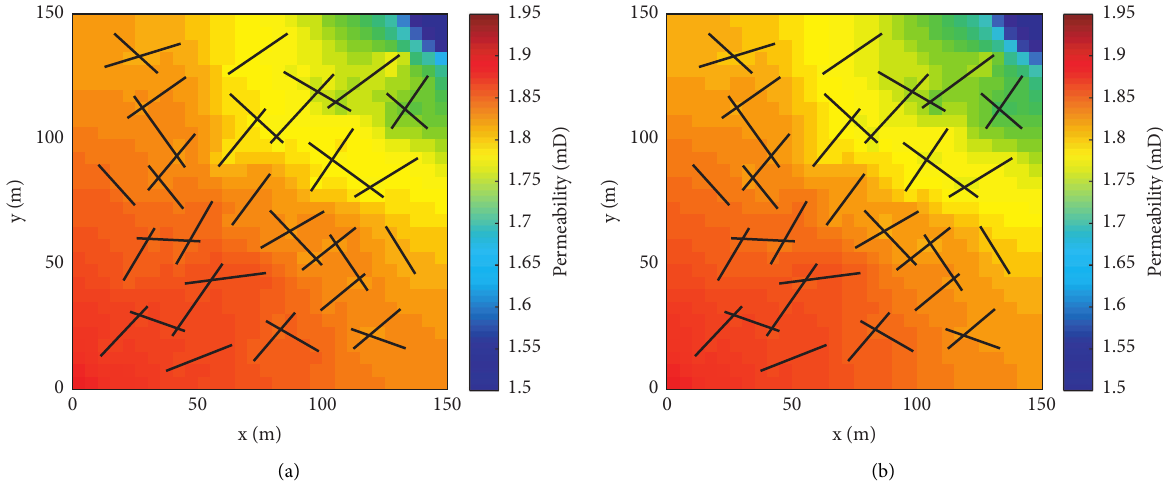
Figure 29: Permeability profiles for (a) pIEDFM and (b) EDFM after 20000days of production.